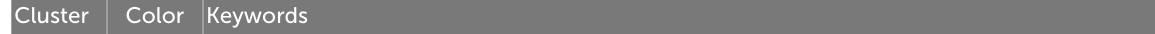
TABLE 9 Cluster of keywords in the traditional Chinese exercises for musculoskeletal